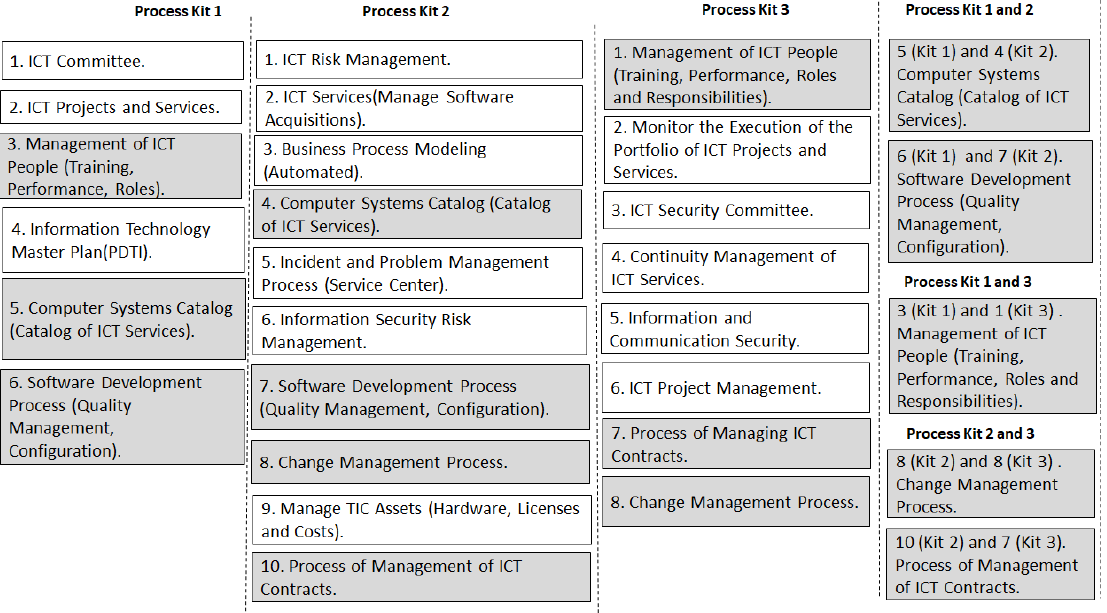
Figure 2. Processes of the ICT Governance